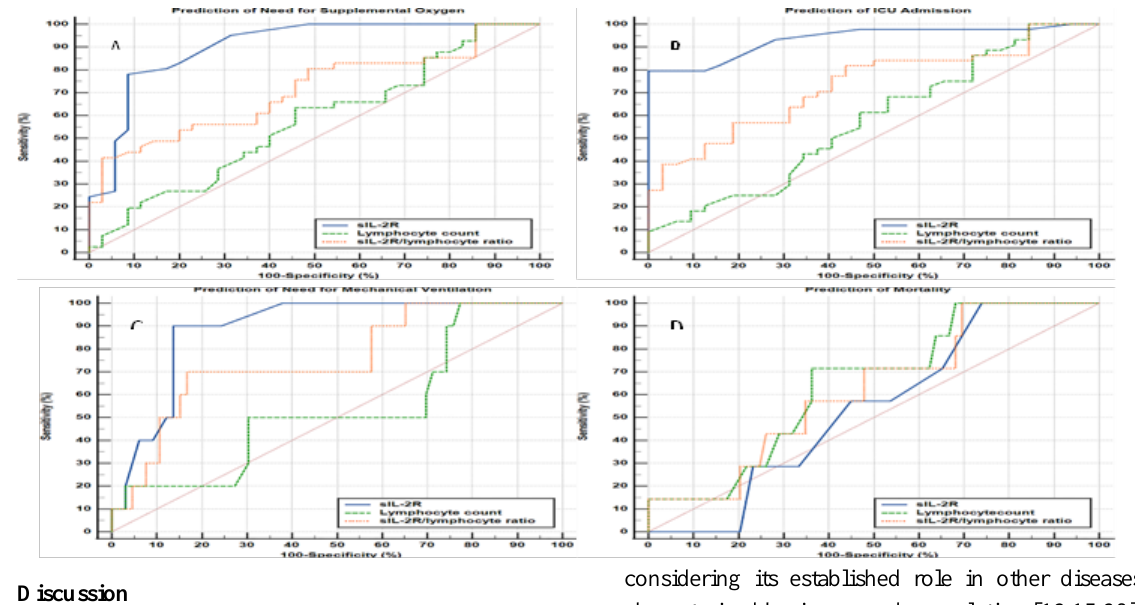
Figure 2. ROC curves illustrating performance of sIL-2R, lymphocyte count, and sIL-2R/lymphocyte ratio in predicting clinical outcome in COVID-19 pediatric patients A) Need for supplemental oxygen (sIL-2R: AUC=0.904, lymphocyte count: AUC=0.572, and sIL- 2R/lymphocyte: AUC=0.709) B) ICU admission (sIL-2R: AUC=0.935, lymphocyte count: AUC=0.576, and sIL-2R/lymphocyte: AUC=0.733) C) Need for mechanical ventilation (sIL-2R: AUC=0.892, lymphocyte count: AUC=0.542, and sIL- 2R/lymphocyte: